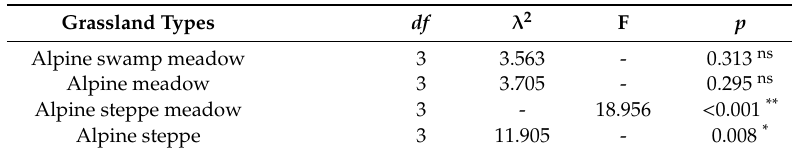
Figure 8. Fractional vegetation cover ( a ) and bare patch area fraction ( b ) of four typical alpine grasslands. Red dots mean the average value. Blue dots are the value of all sampling sites (n = 55). The blue bold solid horizontal lines are the median value. ASwM, AM, AStM and AS indicate alpine swamp meadow, alpine meadow, alpine steppe meadow and alpine steppe, respectively.